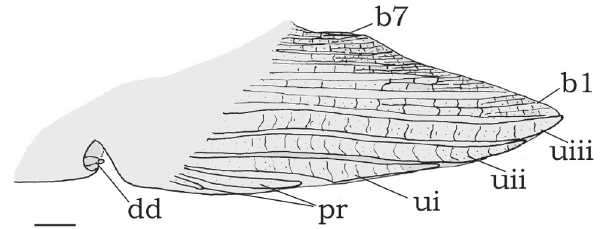
Fig. 6. Male modified anal fin of Centromochlus britskii , MZUSP 43251, paratype, 38.6 mm SL. Left side in lateral view. Abbreviations: b1 , first branched ray; b7 , seventh branched ray; dd , deferent duct; pr , unsegmented procurrent anal fin rays (not counted); ui , unbranched first ray; uii , second unbranched ray; uiii , third unbranched ray. Scale bar =1 mm.